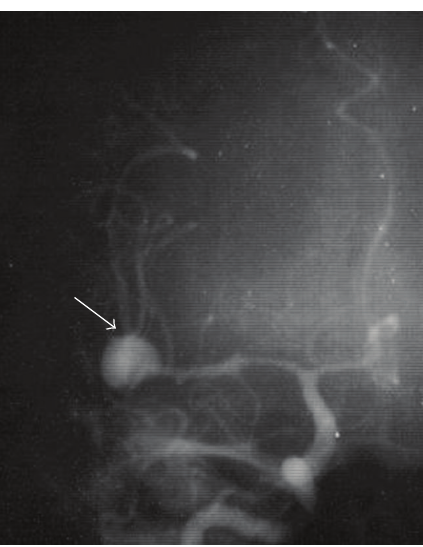
Figure 1: Anteroposterior view of the right carotid angiography showing an aneurysm (arrow) at the bifurcation of the right middle cerebral artery.